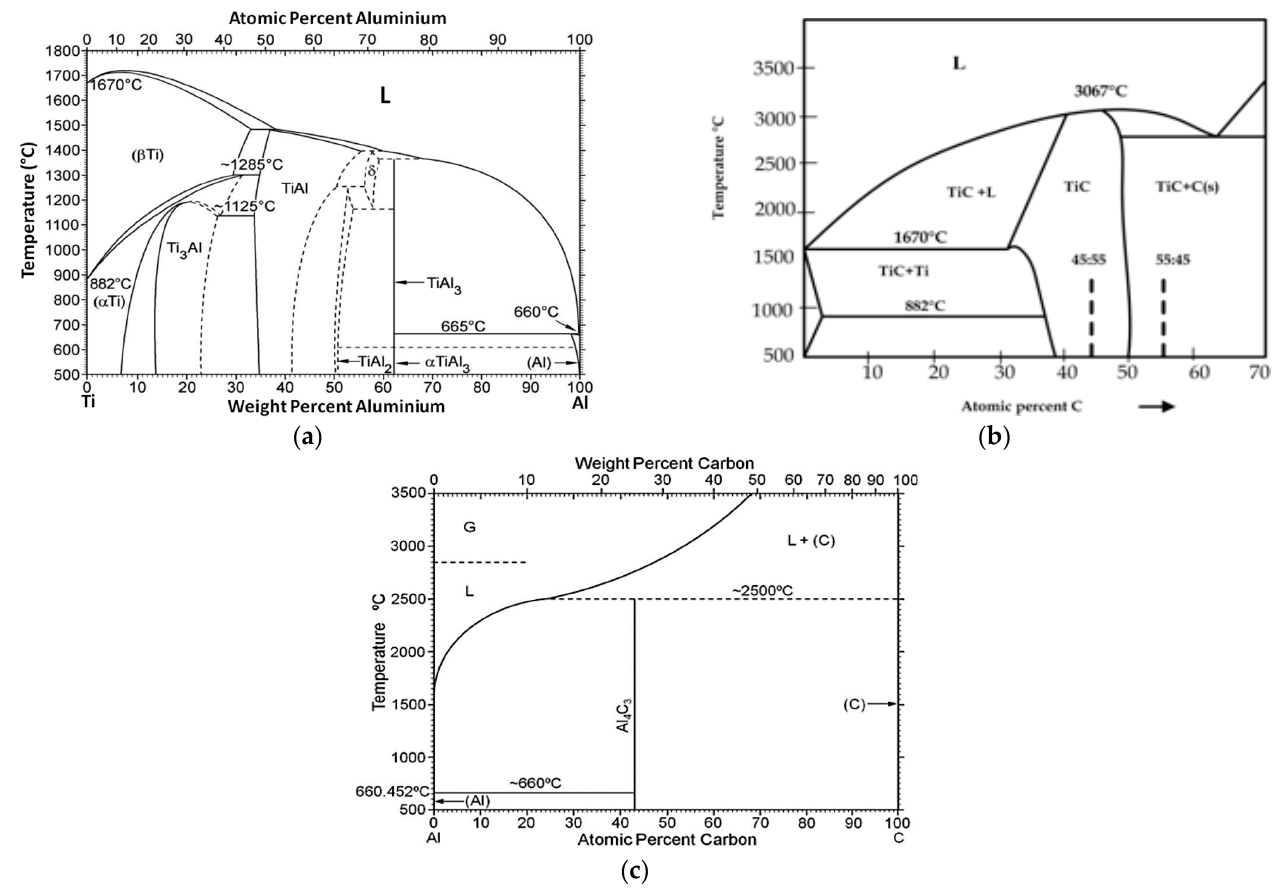
Figure 1. Phase diagram for ( a ) Ti-Al system [19]; ( b ) Ti-C system [22]; ( c ) Al-C system [23]; L—liquid, G—gas, C—carbon.